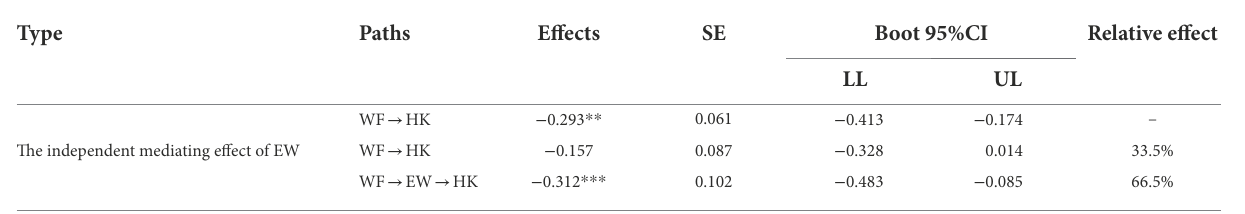
TABLE 4 The results of bootstrap.